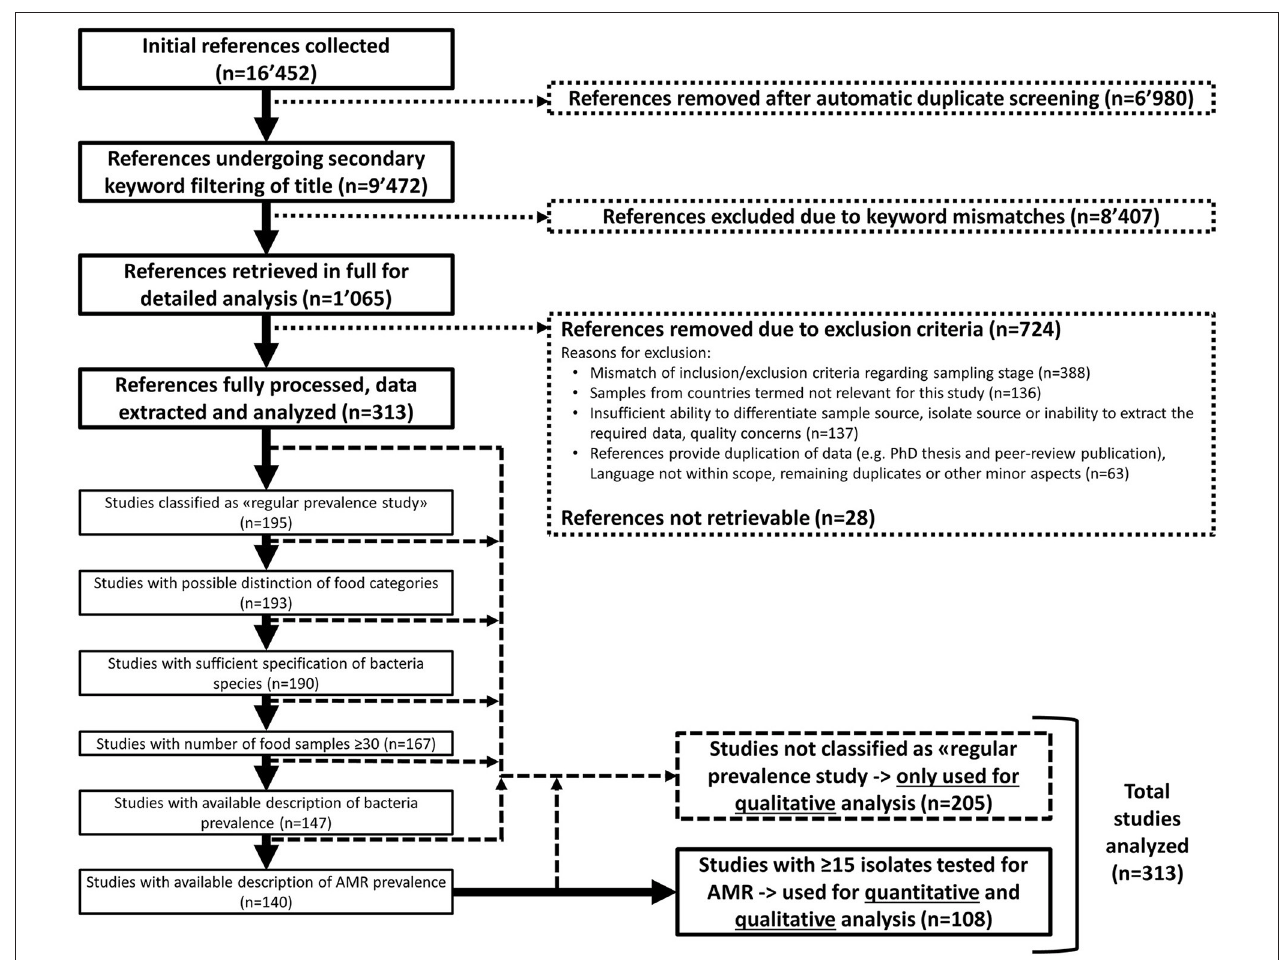
FIGURE 1 | Article selection process for quantitative and qualitative analysis. inclusion criteria e.g., because samples were obtained not at retail level but from abattoirs, farm environments, animals, or humans ( Figure 1